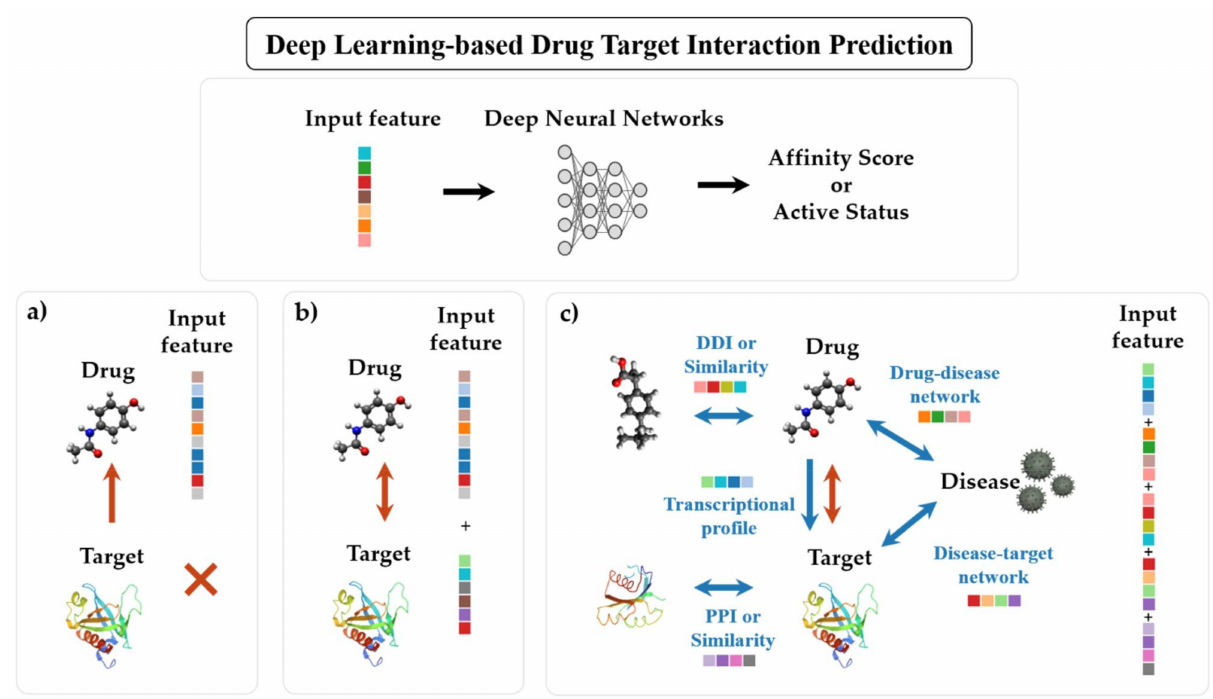
Figure 2. Deep learning-based drug–target interaction prediction. DL-based DTI prediction methods can be grouped based on their input features into three branches: ( a ) ligand-based approach, ( b ) structure-based approach, ( c ) relationship- based